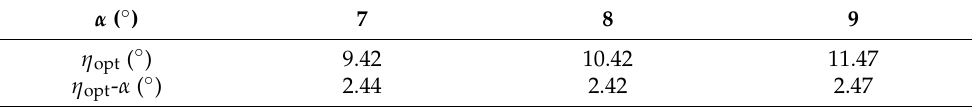
Table 4. Influence of angle of attack on optimal installation angle.